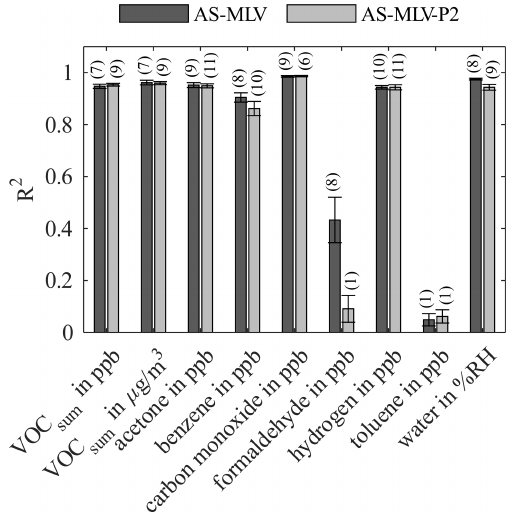
Figure 5. Coefficient of determination ( R 2 ) for AS-MLV and AS- MLV-P2 for different models. Calculation of the regression model with the complete dataset with 10-fold nested cross-validation for hyperparameter optimization (PLSR components) and testing. The number of PLSR components of the model, determined with Eq. (2), is given in